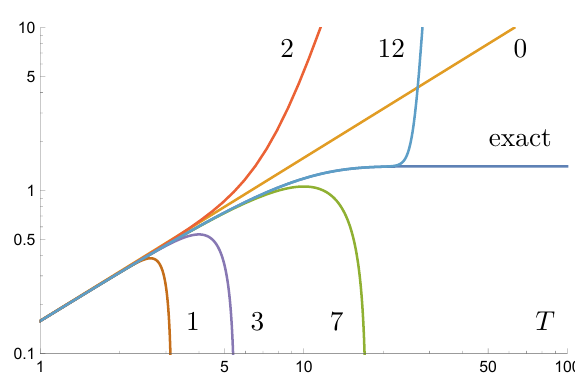
Figure 1 . The double scaling limit of the sum over genus g wormholes in the Airy model, up to g = g max (numbers shown) with e S 0 = 10 and β = 1 / 2